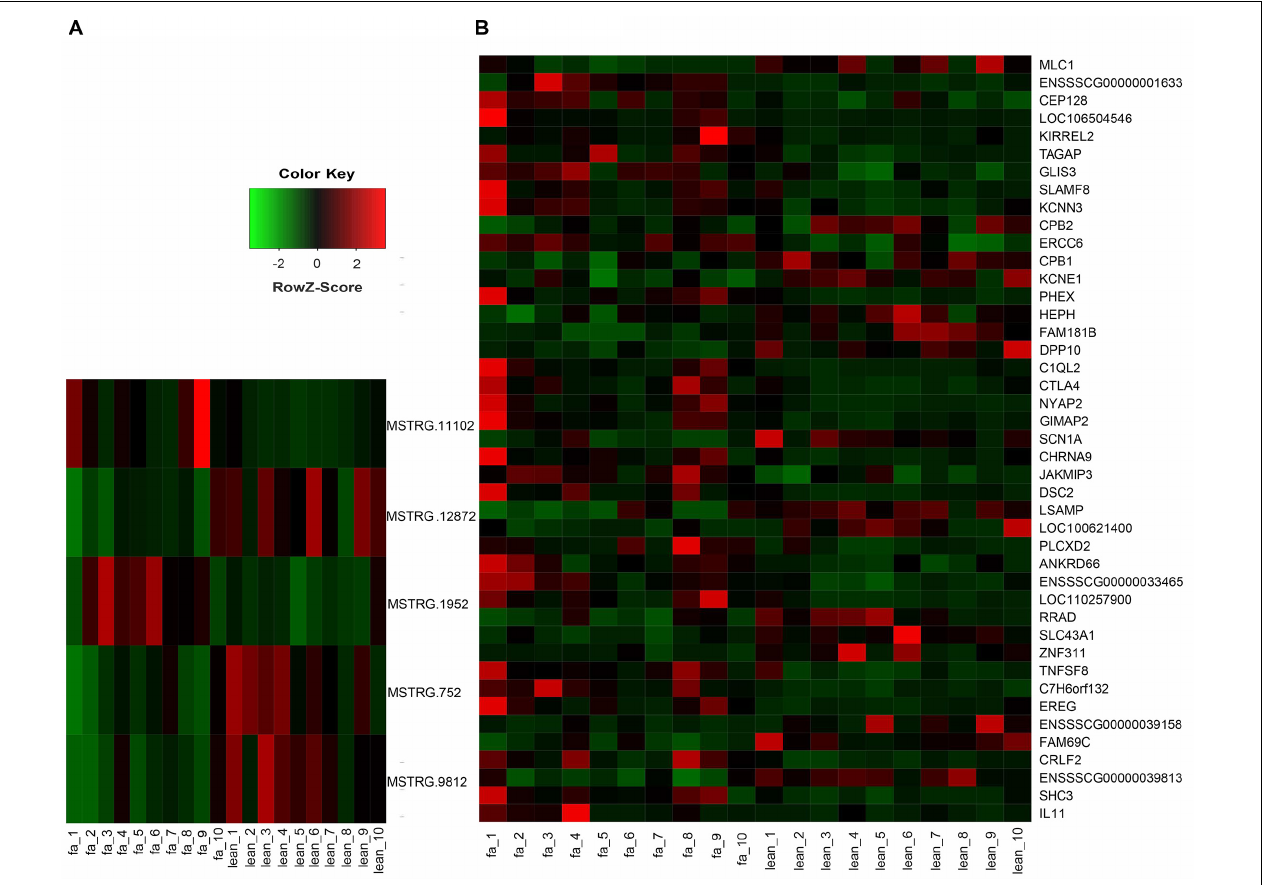
FIGURE 3 | (A) Heat map of five DEL genes between fat and lean samples. (B) Heat map of 43 differentially expressed protein-coding genes between fat and lean samples. Red represents an increase in expression, while green reduces